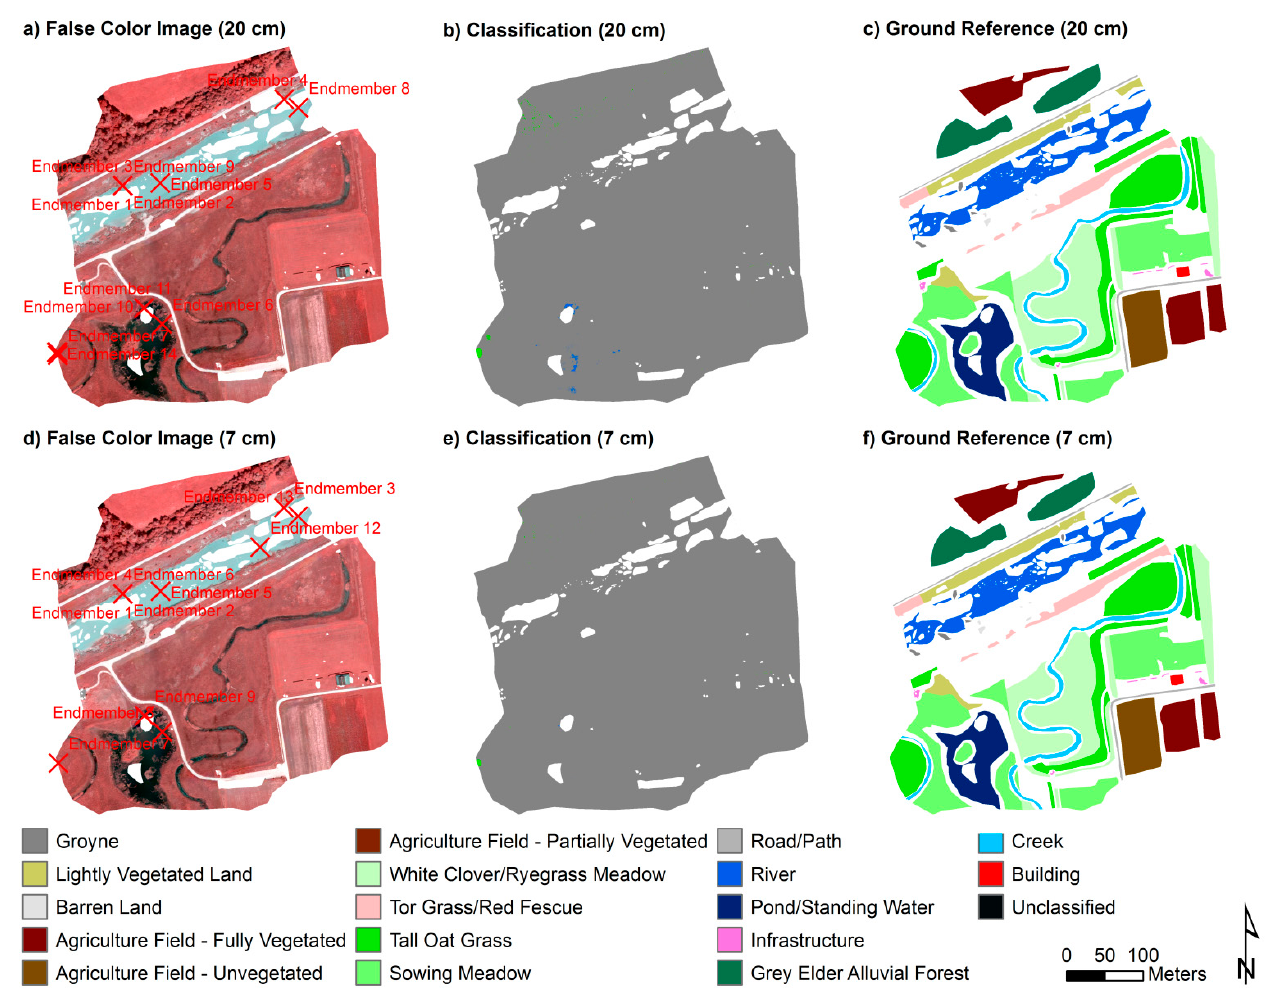
Figure 13. ( a ) Narrow-band image from 29 July 2016 of the River Gail study area with extreme/erroneous pixels masked out at the 20 cm pixel size. The map also shows locations of the identified purest pixels extracted as endmembers and used in the classification; ( b ) Land cover classification generated using the 20 cm narrow-band image, endmembers extracted from ( a ), and the Spectral Angle Mapper algorithm within ENVI; ( c ) Reference data used in assessing the accuracy of the classified image in ( b ); ( d ) Narrow-band image from 29 July 2016 of the River Gail study area with extreme/erroneous pixels masked out at the 7 cm pixel size. The map also shows locations of the identified purest pixels extracted as endmembers and used in the classification; e ) Land cover classification generated using the 7 cm narrow-band image, endmembers extracted from ( d ), and the Spectral Angle Mapper algorithm; ( f ) Reference data used in assessing the accuracy of the classified image in ( e ).